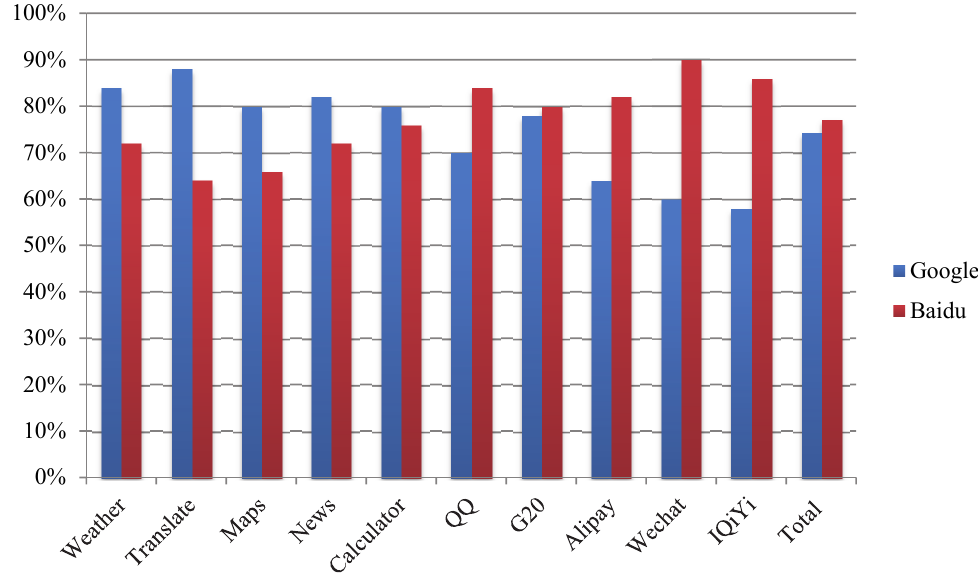
Fig. 5. Comparison of Precision in Google and Baidu